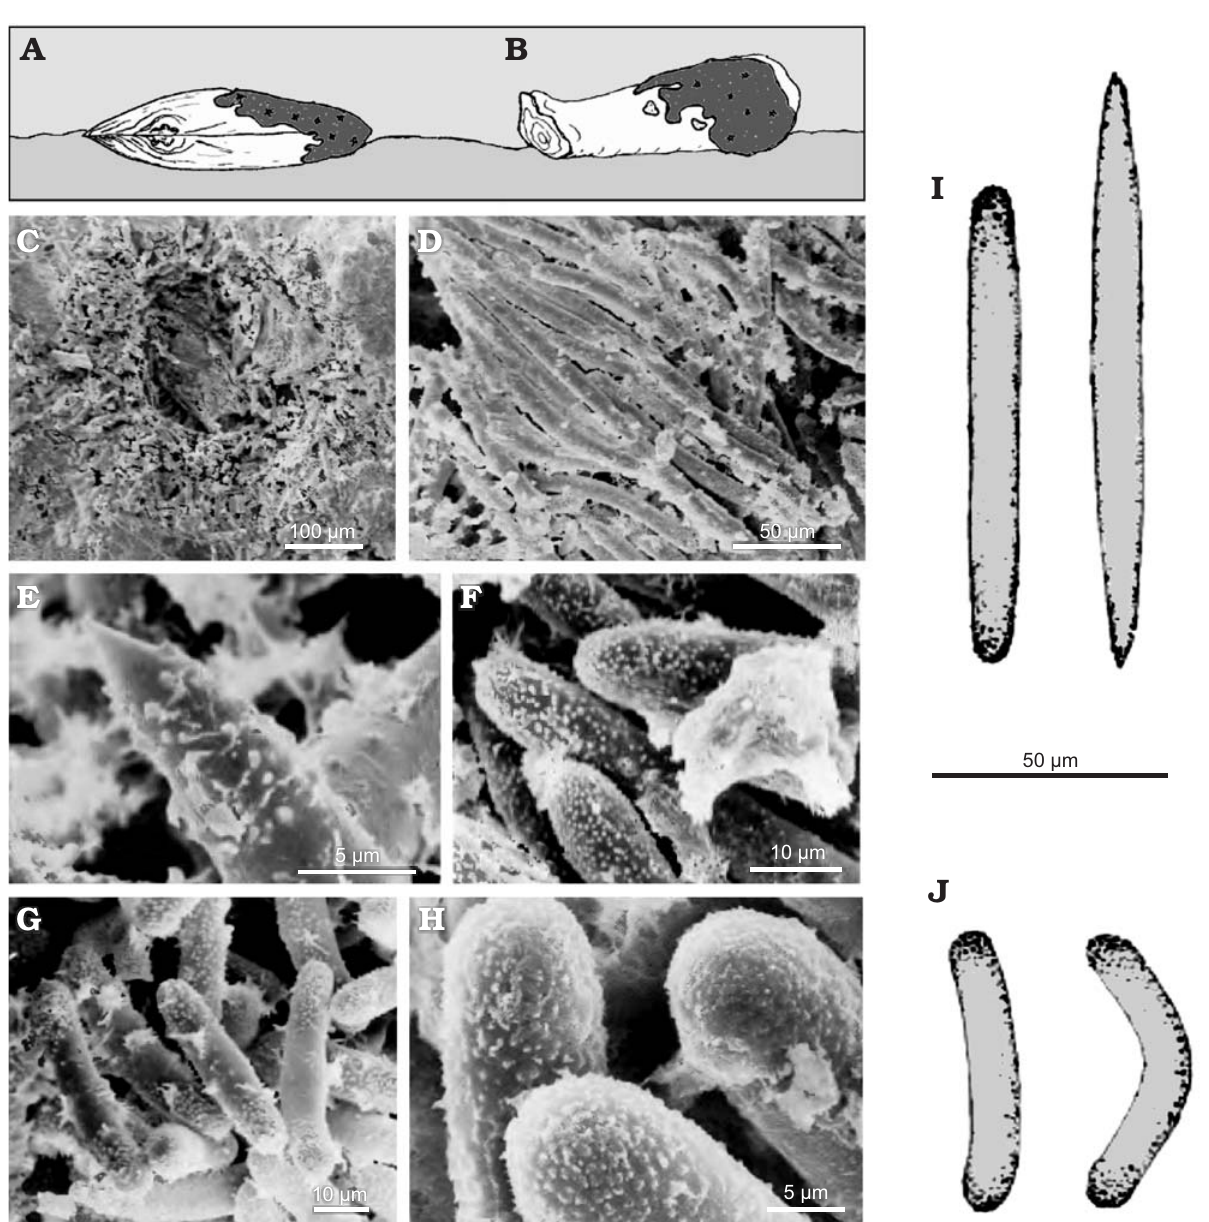
Fig. 19. Oncosclera kaniensis Matsuoka and Masuda, 2000, Spongillida: Potamolepidae, TMNH; Nakamura Formation, early Miocene, River bed on the Kiso River, Dota, Gifu Prefecture, Central Japan. A . Sponge encrusting a shell ( Anodonta , Mollusca, Bivalvia). B . Sponge encrusting a wood frag- ment retaining its annual rings. C . Gemmule (cross section). D . Megascleres. E . Oxea tip (megasclere). F . Strongyles tips (megasclere). G . Strongyles (gemmuloscleres). H . Spiny tips of strongyles (gemmuloscleres). I . Strongyle and oxea (megascleres). J . Strongyles (gemmuloscleres). A, B,